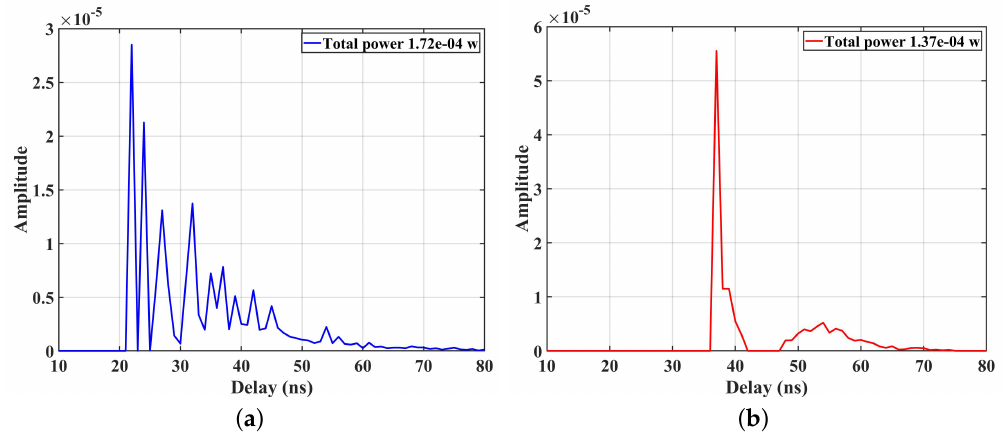
Figure 7. ( a ) The CIR before optimization; ( b ) the CIR after optimization.